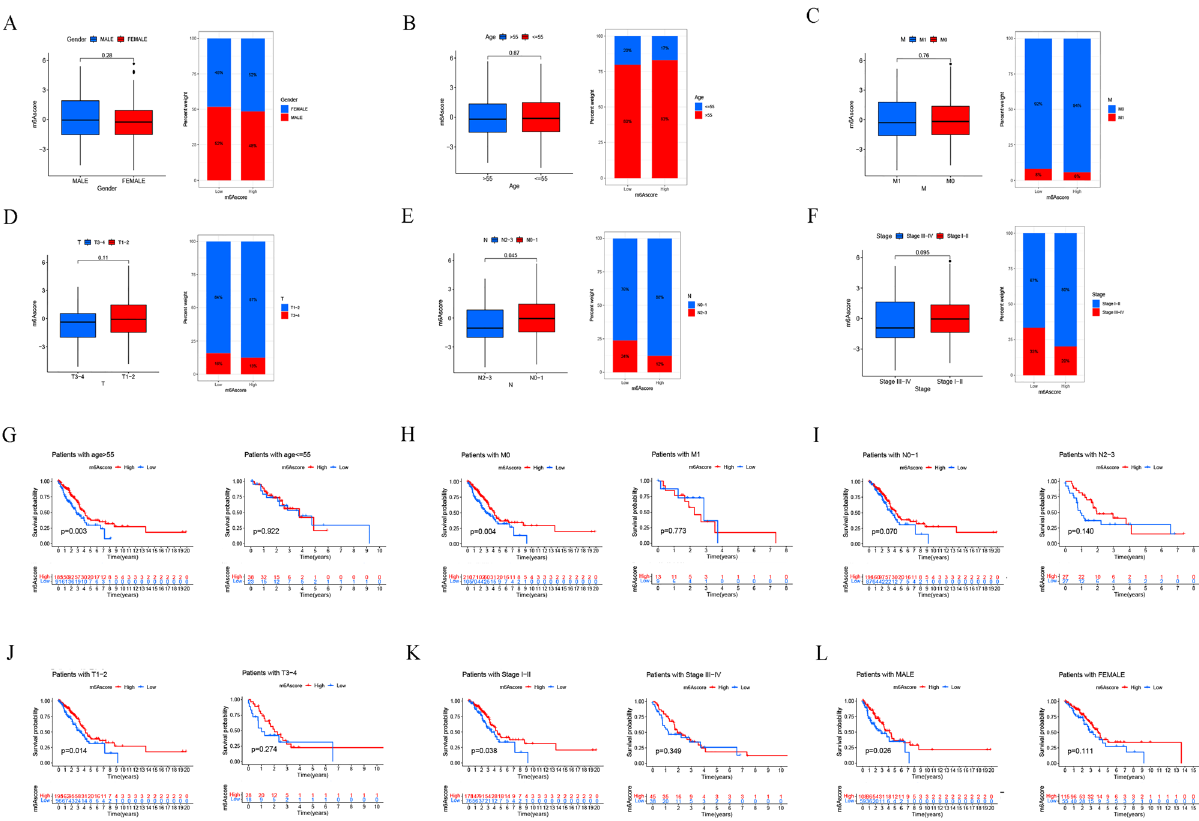
Figure 5. Clinical characteristics of m 6 Ascore cluster in TCGA-LUAD cohort. ( A – F ) Correlation analysis between clinical characteristics and m 6 Ascore. ( G – L ) Correlation analysis between m 6 Ascore and prognosis in different patient